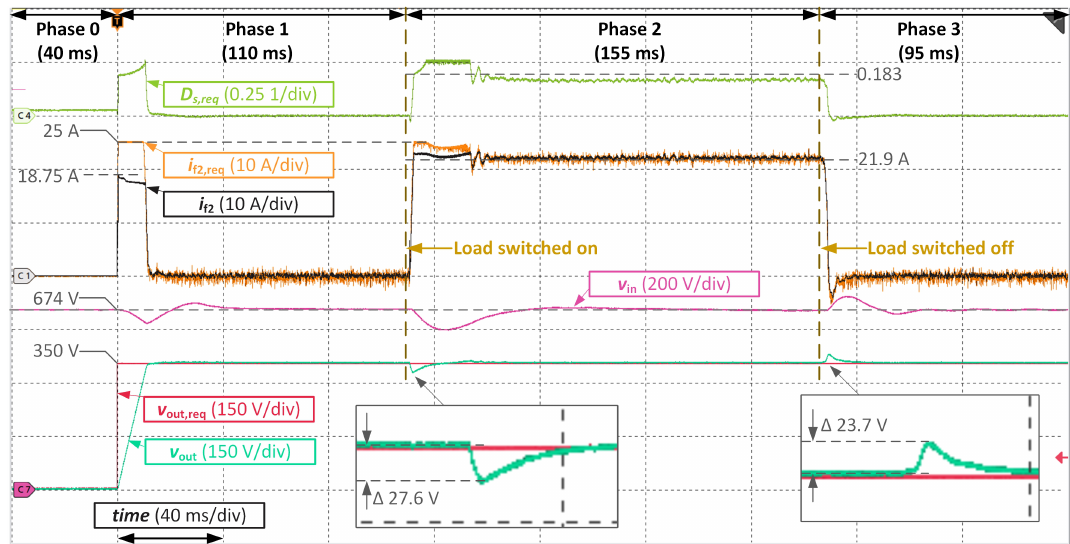
Figure 19. Experimental results for voltage controller tuned with reduced dynamics : reference voltage value for the active rectifier v in,ref = 670 V, reference output voltage value for the DAB converter v out,ref = 350 V, additional current limitation I spec = 25 A, resistive load R = 16 Ω